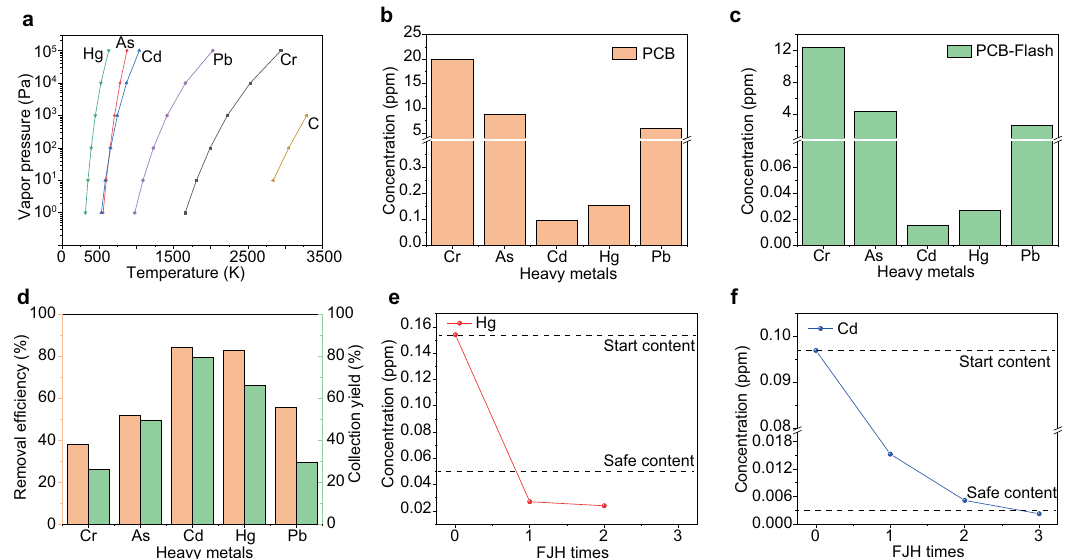
Fig. 4 Removal of heavy metals in e-waste by fl ash Joule heating (FJH) process. a Vapor pressure – temperature relationships of toxic heavy metals and carbon. b Concentrations of toxic heavy metals in the printed circuit board (PCB). c Concentrations of toxic heavy metals in PCB after FJH. d Removal ef fi ciency and collection yield of heavy metals. The ef fi ciency and yield were the average of three independent FJH experiments ( n = 3). e Concentration of Hg in the residues after multiple FJH reactions. f Concentration of Cd in the residues after multiple FJH reactions. The dashed lines in ( e , f ) represent the starting contents and the approved World Health Organization (WHO) level for safe limits of agricultural